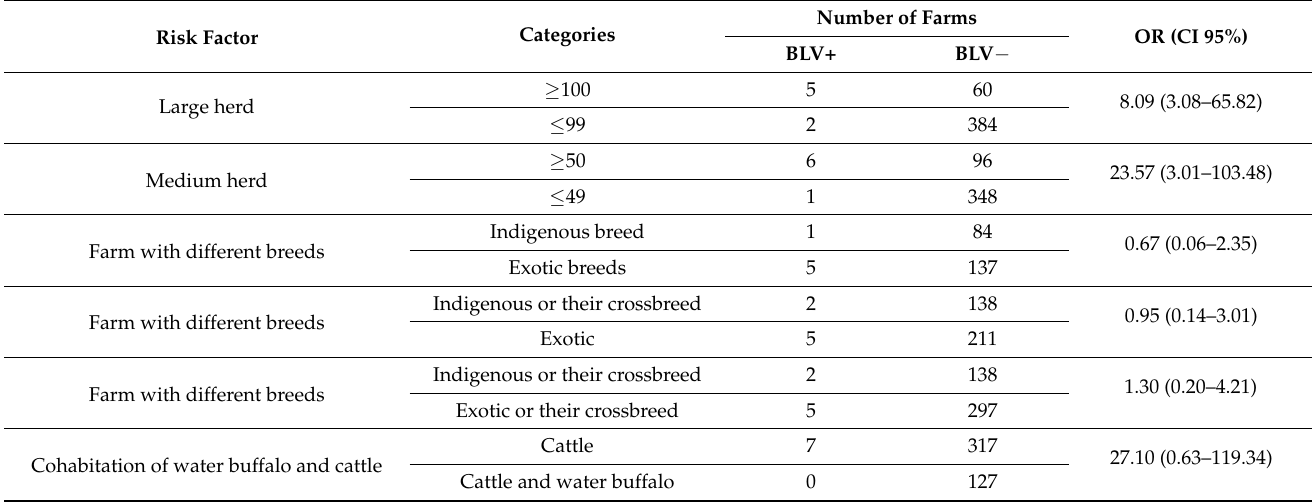
Table 3. Risk factors associated with seropositivity to BLV infection in